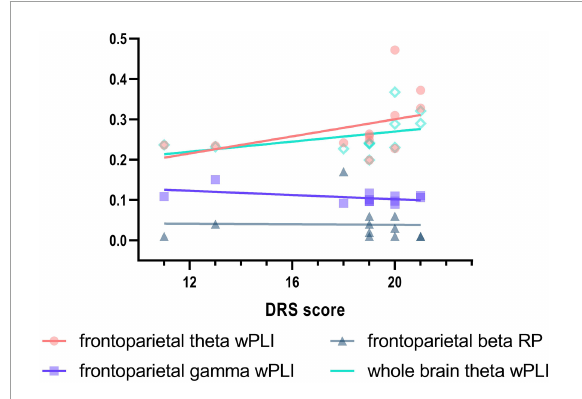
FIGURE4 Correlation between Disability Rating Scale (DRS) scores and EEG activity in EMCS patients. Spearman’s correlations between DRS and frontoparietal theta wPLI ( r s = 0.629, P = 0.029), frontoparietal gamma wPLI ( r s = –0.047, P = 0.885), frontoparietal beta relative power ( r s = –0.445, P = 0.147), and whole brain theta wPLI ( r s = 0.650, P = 0.022) in EMCS patients. Linear regression was used to generate fitted lines for each data